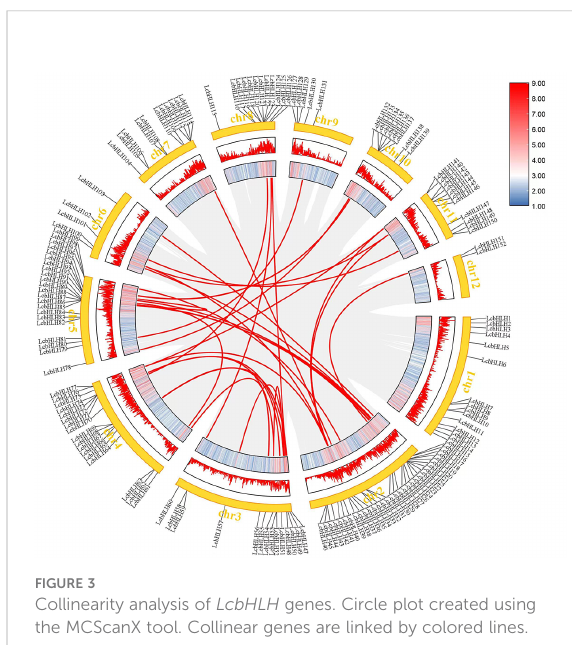
FIGURE 2 Chromosomal distribution of LcbHLH genes. LcbHLH genes (159) were unevenly mapped on 12 chromosomes. Tandem duplicated gene pairs are displayed with red color.